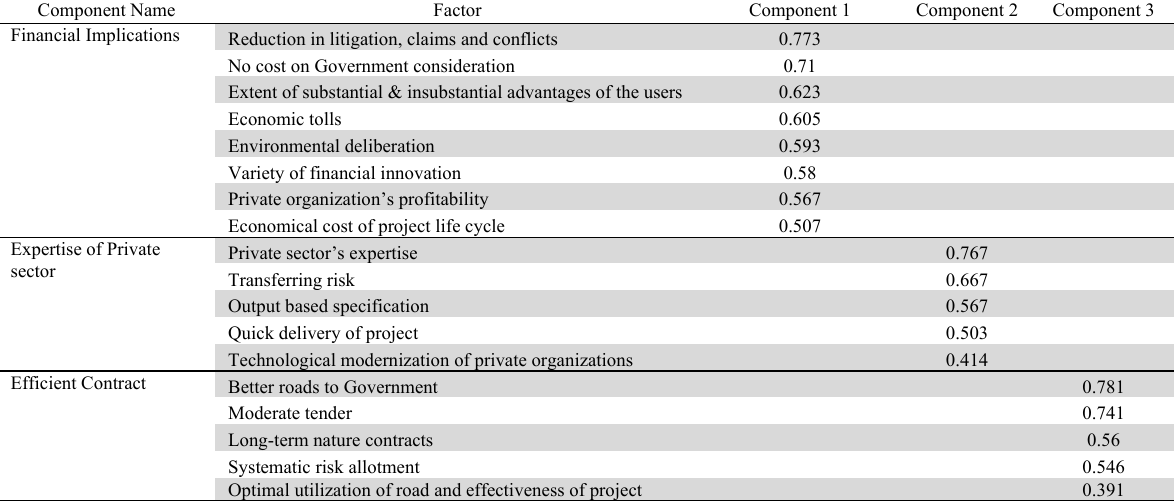
Fig. 1. Scree plot for VFM factors Fig. 1 represents the elbow shape which indicates that the factors can be separated into three parts. Table 2 represents the rotated component matrix for three factors which represents the factor loadings. The values of factor coefficients less than 0.3 are not considered (Mathur, 2014; Malek, 2016). Grouping results after Rotated Factor Matrix for VFM